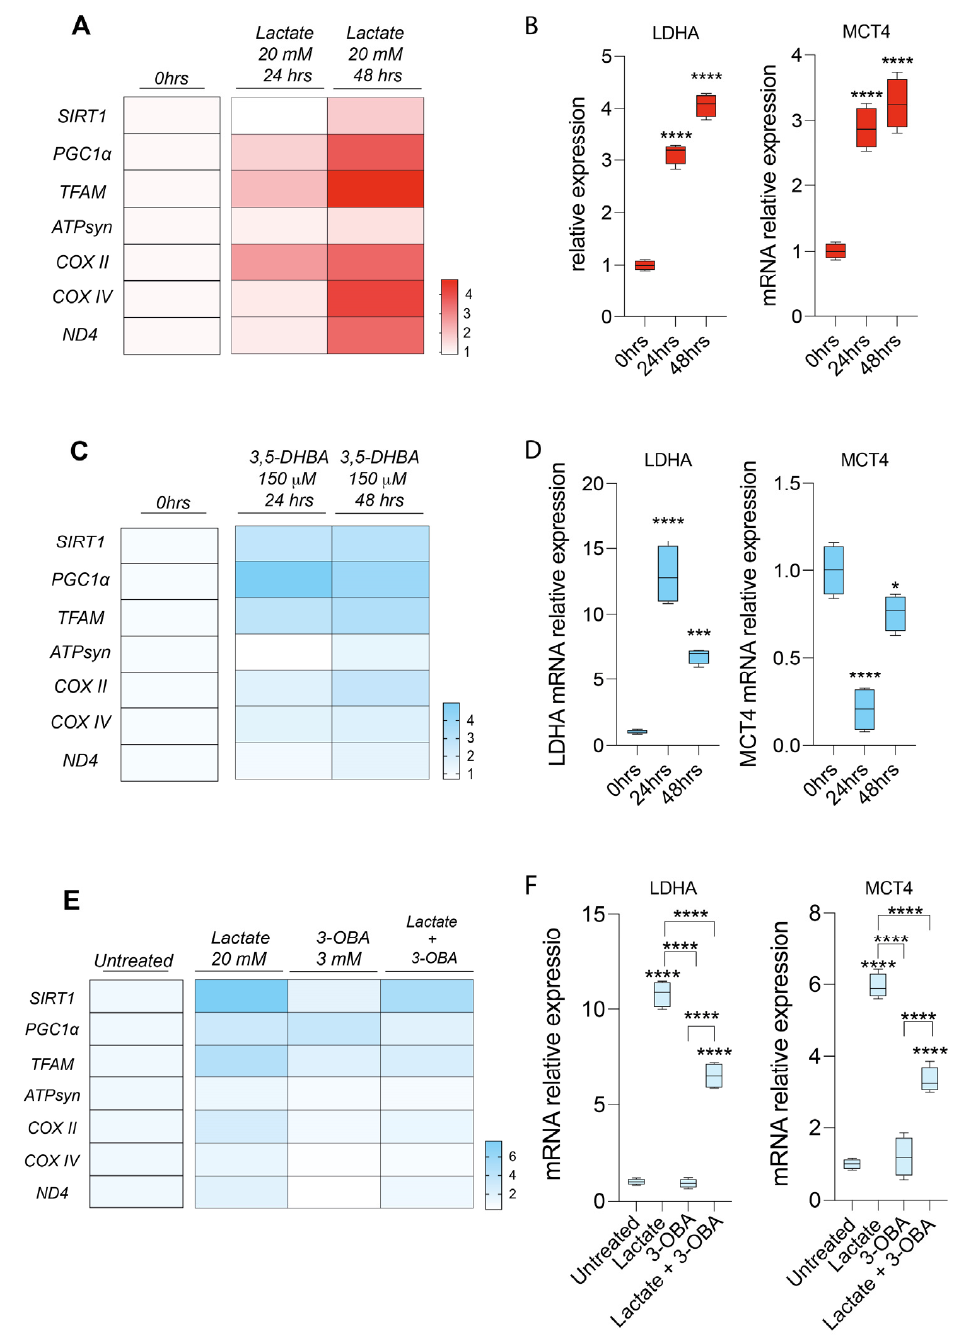
toward oxidative metabolism.